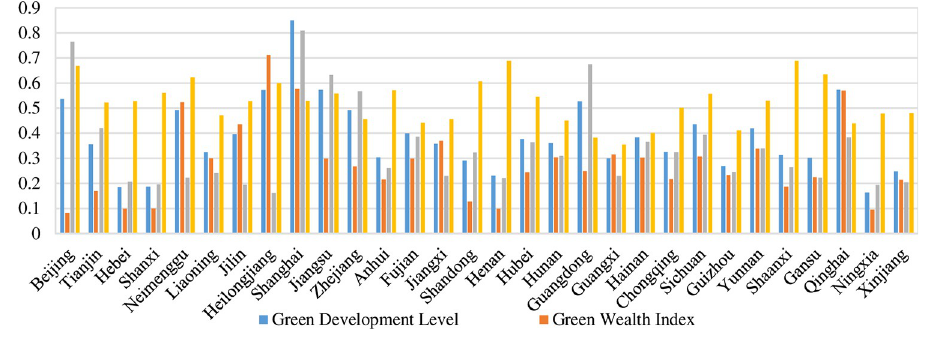
Fig 4. China’s green development level and its composition in